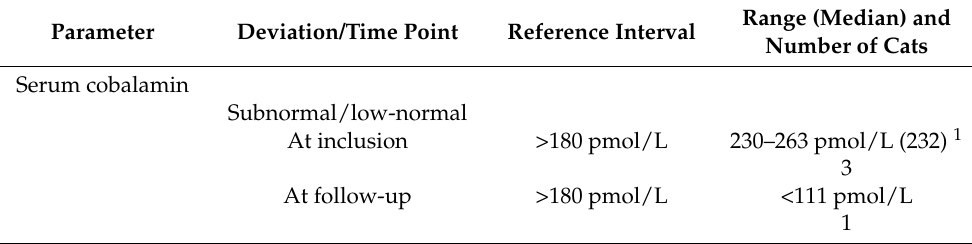
Table 4. Selected serum chemistry and hematology results at inclusion and from inclusion to follow- up in 19 cats with presumed chronic pancreatitis treated with